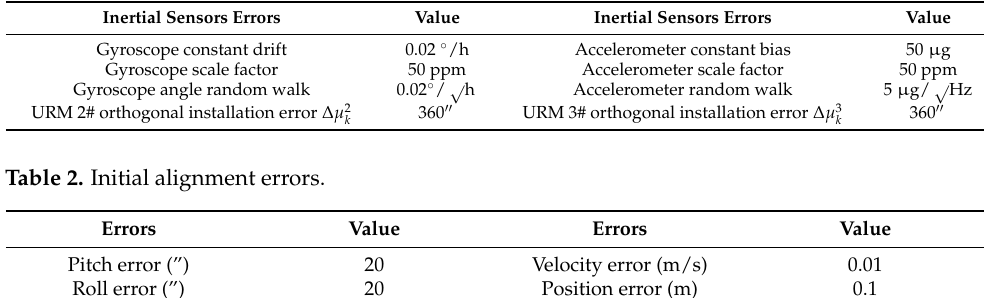
Table 1. Set the errors used in the simulation.